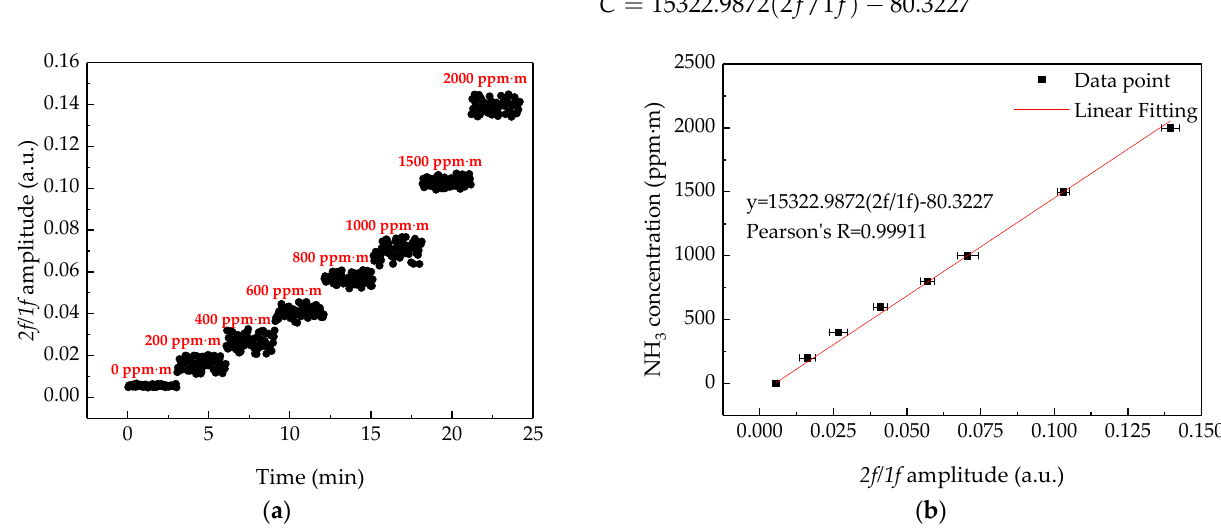
Figure 5. ( a ) Calibration of system by using a gas sampling bag with integral concentration from 0ppm·m to 2000 ppm·m, each concentration level was measured and recorded for about 3 min. ( b ) Measured data dots and linear fitting curve of the NH 3 integral concentration versus 2f/1f signal amplitude.